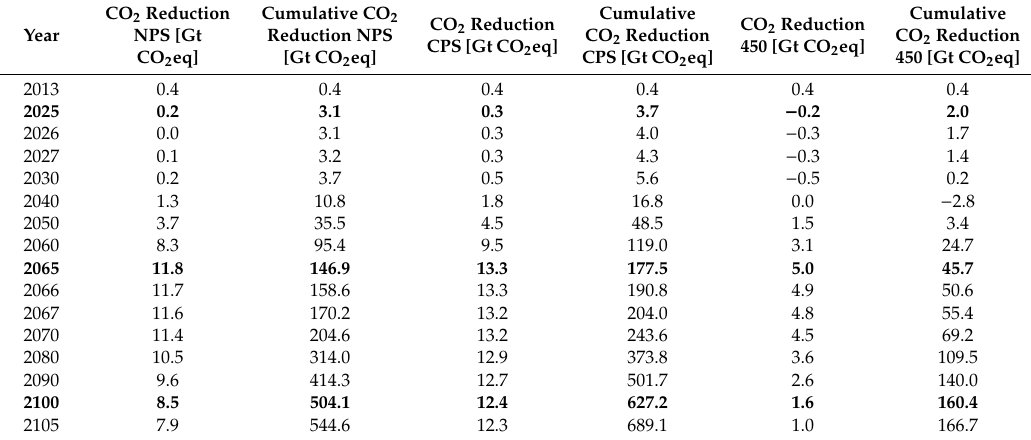
Table 7. Possible CO 2 emission reduction for scenario S1, sub scenario